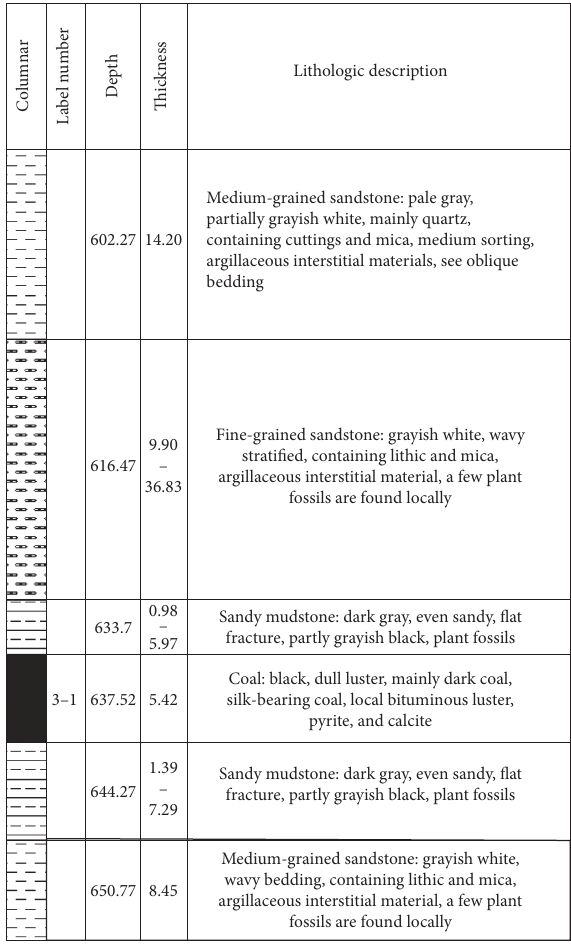
Figure 2: 3-1 coal roof and floor lithology column